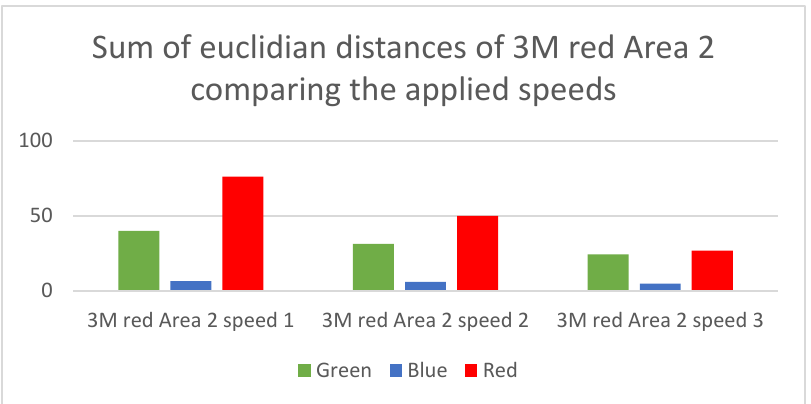
Figure 7. Sum of Euclidian distances between the scenario “3M red Area 2 speed 4” and the scenarios with the other speed levels for this foil and size configuration.